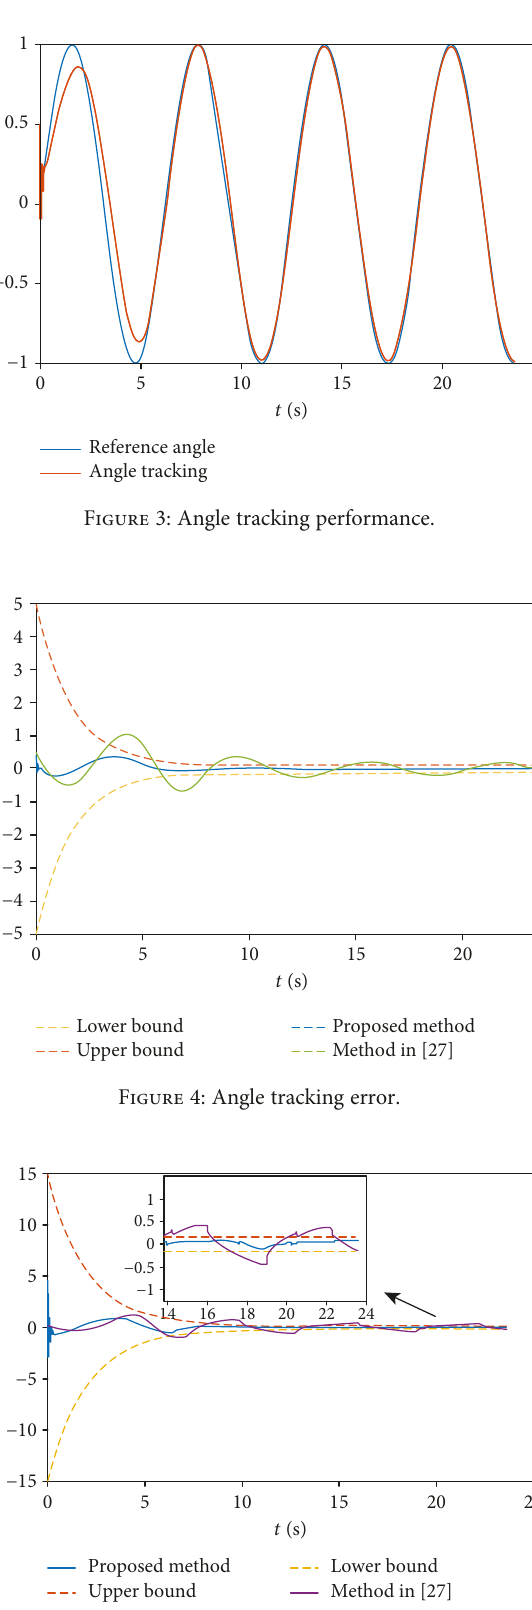
Figure 5: Angular velocity tracking error.